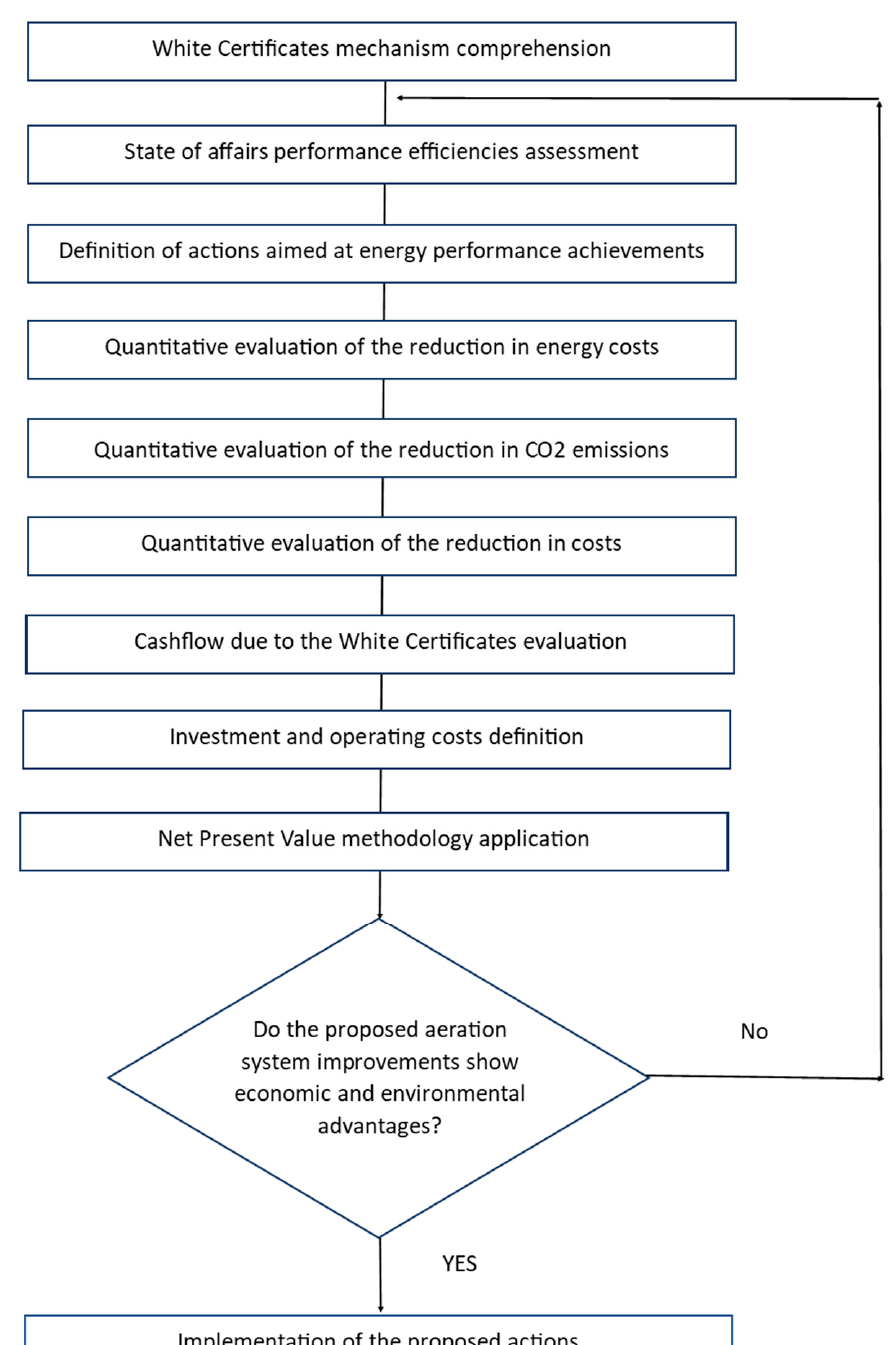
Figure 3. Guide for operations.